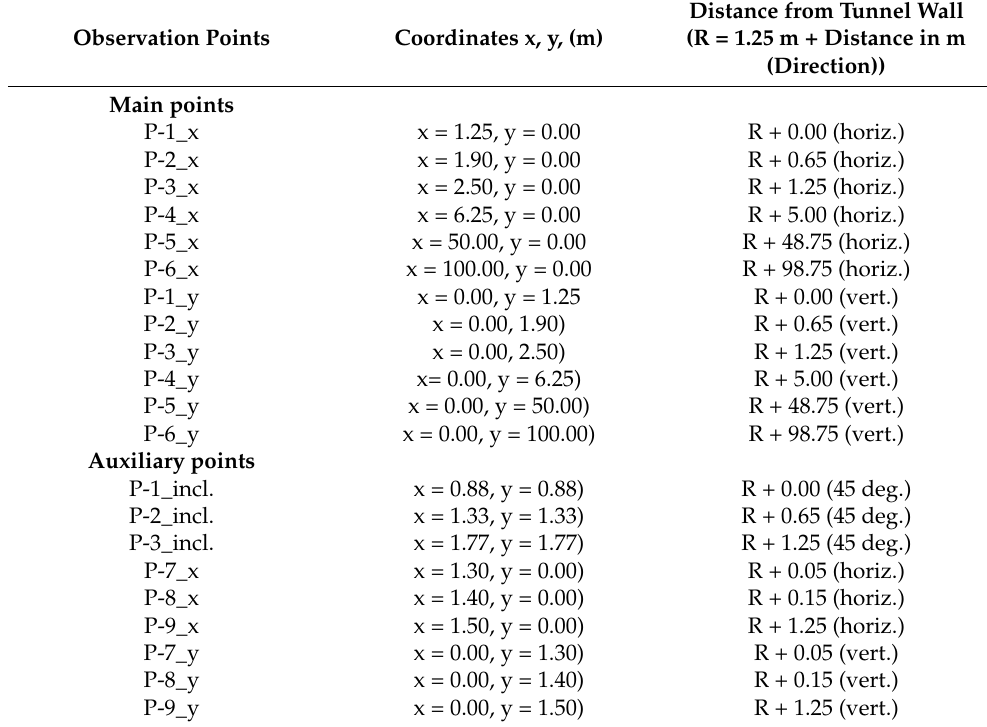
Table 1. Observation points for THM analysis (adapted from [11]).